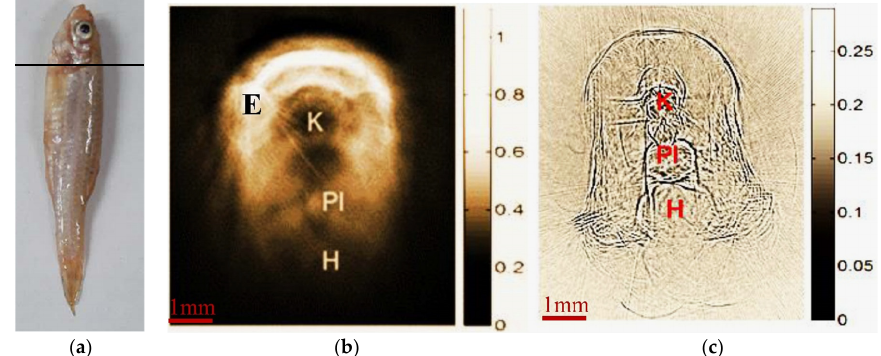
Figure 5. ( a ) The photograph of the adult zebrafish, in which the black line denotes the imaging slice of the zebrafish. The PA images were recovered using a 10 MHz unfocused transducer ( b ) and a focused one ( c ). Here, K denotes kidney, P denotes posterior intestine, H denotes heart, and E denotes eyes. The gray scale (right) records the PA signals in a relative unit, whereas the color scale (right) illustrates the spatial scale, in mm.